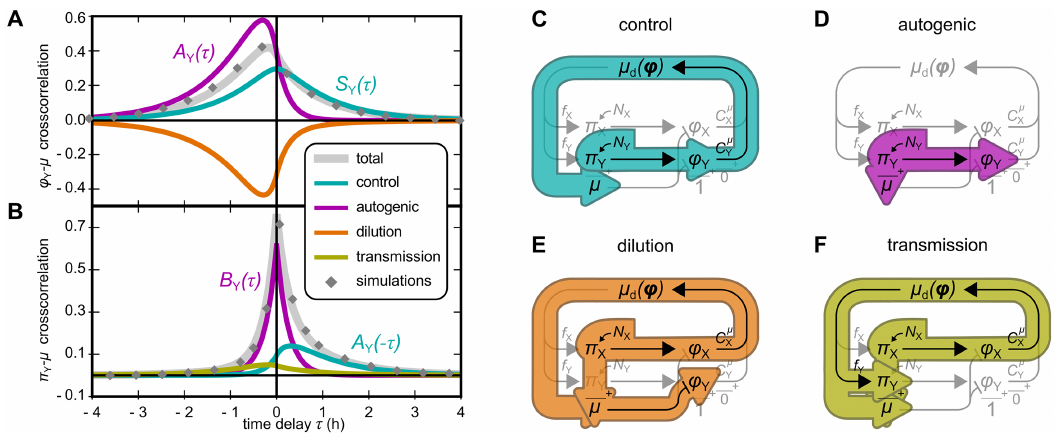
Fig 3. Noise modes in a toy model containing only two protein species, X and Y. ( A ) Analytical solution for the cross-correlation between protein Y’s proteome fraction ϕ Y and growth rate μ (gray curve), verified by simulations (gray diamonds, details in S1 Text, p. 9). The contributing noise modes are indicated (colored curves). ( B ) Same as (A), but for the synthesis rate π Y . The cross- correlation functions are linear combinations of three classes of functions, called A (49) for their definitions). In panels (A) and (B), noise modes that are proportional to just one of these functions are annotated accordingly. ( C )–( F )Noise propagation routes underlying the noise modes. The control mode and the autogenic mode arise from noise source N Y alone. Both noise sources N X and N Y contribute to the dilution and transmission modes, but only the contribution of N X is illustrated in Fig (D) and (F). Parameters for (A) and (B): C μ of N Y and N X have amplitudes θ Y = 0.5 and θ X = 0.5 and reversion rates β Y = β X = 4 μ 0